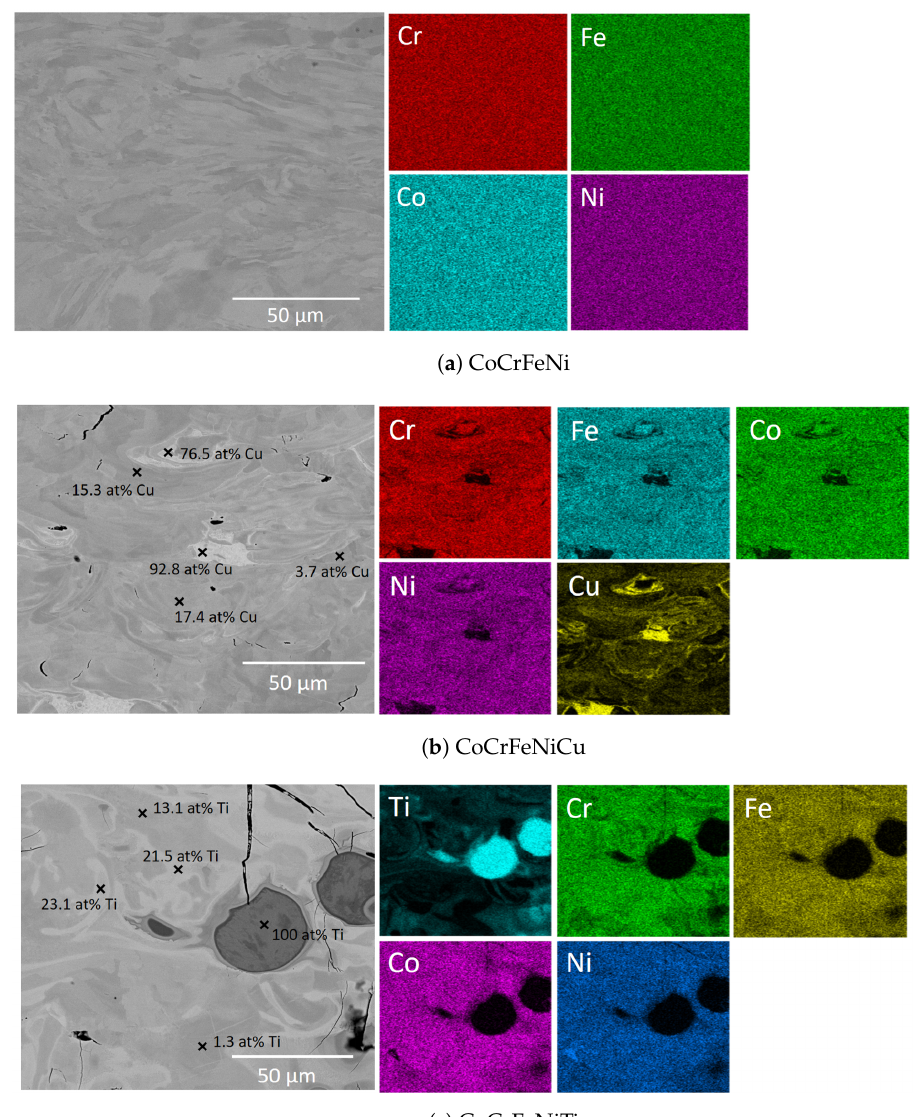
Figure 5. Back Scattered Electron (BSE) images and accompanying EDS scans of the ( a ) CoCrFeNi, ( b ) CoCrFeNiCu and ( c ) CoCrFeNiTi alloys. EDS point scans showing the variation in concentration of Cu and Ti have also been shown, where all other elements remained